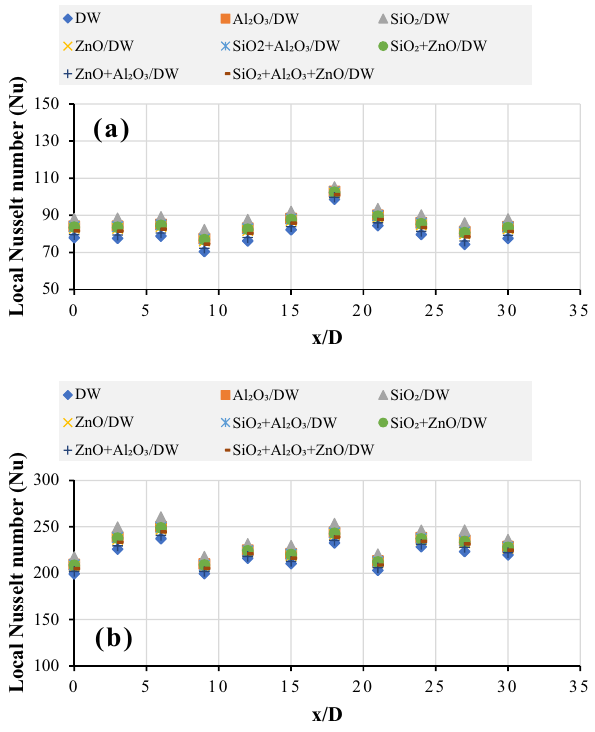
Figure 7: Comparison of the local Nusselt number and the non - dimensional axial distance ( x / D ) at Re = 9,000 and 4vol% of various nano fl uid types: ( a ) plain pipe and ( b ) twisted tape pipe.